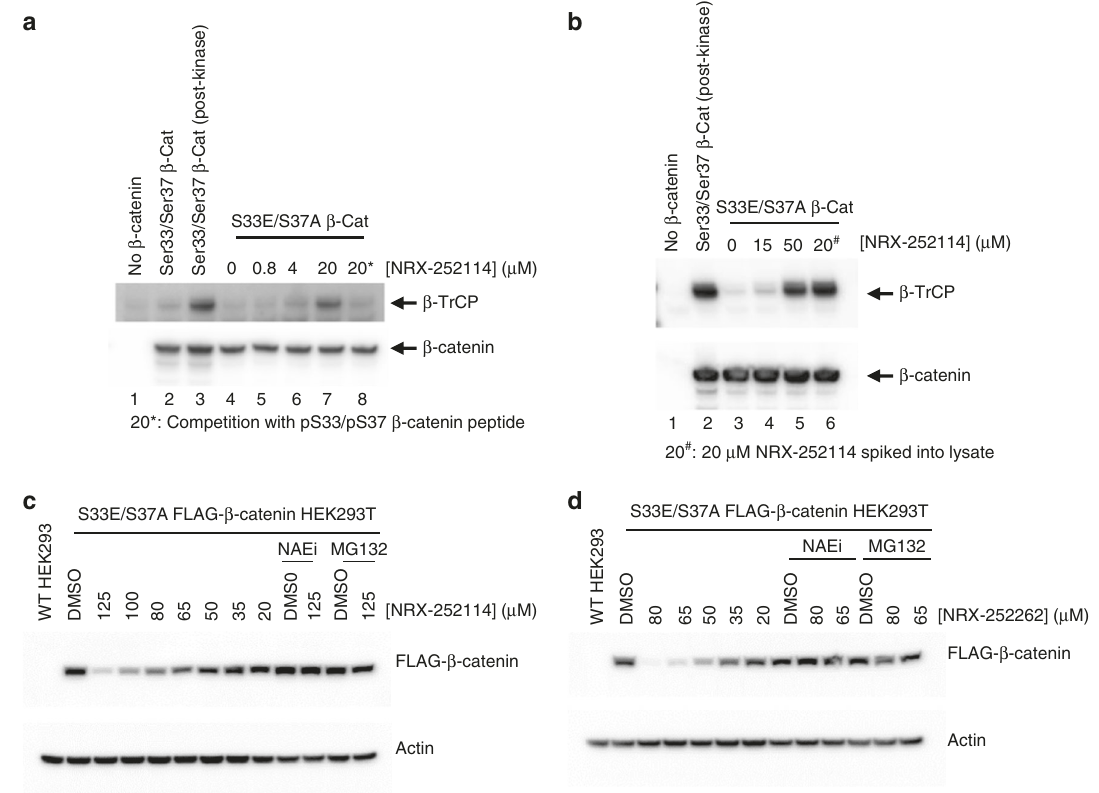
Fig. 6 Enhancers degrade S33E/S37A phosphomimetic β -catenin protein in cells. a Puri fi ed Myc/FLAG-tagged β -catenin protein (as indicated) was mixed with HEK293T cell lysates in the presence of varying amounts of NRX-252114 and immunoprecipitated using anti-myc beads. The samples were resolved on SDS-PAGE and analyzed by immuno-blotting with either C-terminal β -catenin or β -TrCP antibody. In lane 3, 2 μ M β -catenin was phosphorylated with the mix of 1 μ M GSK3, 200 nM CK1 and 50 nM Axin prior to its addition to the lysate. In lane 8, 6.4 μ M pSer33/pSer37 β -catenin peptide was spiked into the lysate prior to the addition of β -catenin protein. b HEK293T cells without (lanes 1 and 2) or with overexpression of S33E/S37A Myc/FLAG-tagged β - catenin (lanes 3-6) were treated with NRX-252114 for 6 h (as indicated). Cells were then lysed, β -catenin was immunoprecipitated using anti-myc beads and probed for either β -catenin or β -TrCP (as described above). In lane 2, cell lysate was spiked with phosphorylated WT Myc/FLAG-tagged β -catenin protein, whereas in lane 6, the lysate was spiked with 20 μ M NRX-252114 as positive controls. c HEK293T cells stably expressing Myc/FLAG-tagged S33E/ S37A β -catenin were treated with varying concentrations of NRX-252114 (as indicated) for 6hrs and examined for S33E/S37A β -catenin levels by western analysis using anti-FLAG antibody. For control, Actin levels were monitored using anti-Actin antibody. For co-treatments, either 5 μ M of Nedd8 E1 inhibitor (NAEi) or 10 μ M of proteasome inhibitor (MG132) were added to cells 30 min prior to the compound treatment. d Same as Fig. 6c, except NRX-252262 was pSer33/S37A peptide (we could not estimate the binding af fi nities due to partial binding curves). In this system, NRX-103094 enhances the S33E/S37A phosphomimetic peptide binding af fi -